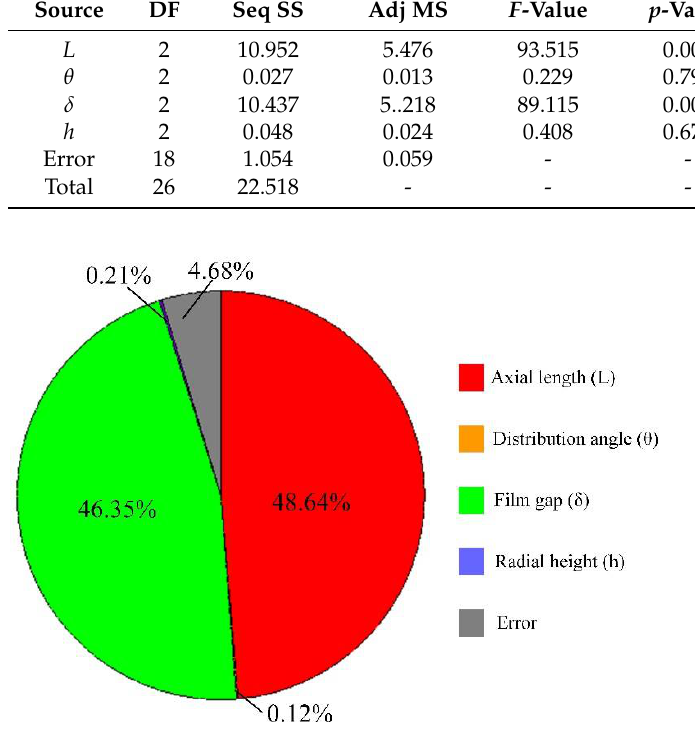
Figure 13. Contribution of structural parameters on stress.